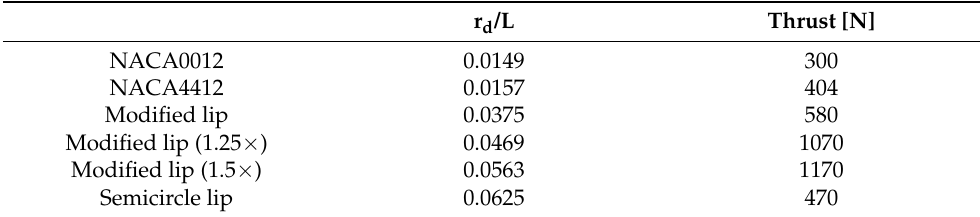
Figure 10. Schematics of the 2D-ducted fan CFD model. The fan disc represented by the virtual disc with momentum sources is set at 0.08 L backward from the foremost lip point. The lip shapes are described in the order of lip radius increasing. The R/L value is used to characterize the geometric characteristics of these shapes. NACA0012 and NACA4412 airfoils are selected in the former two profiles. The third one adopts the lip shape with R/L from 0.0375 to 0.0563, which has a 1/1.25/1.5 proportional amplification of the r d /L value. The fourth one is a semicircle lip. The thrust generated on the duct wall is extracted with the same position and pres- sure step value of the fan boundary in the simulation model, as shown in Table 6. Table 6. The thrust of different duct wall shapes.